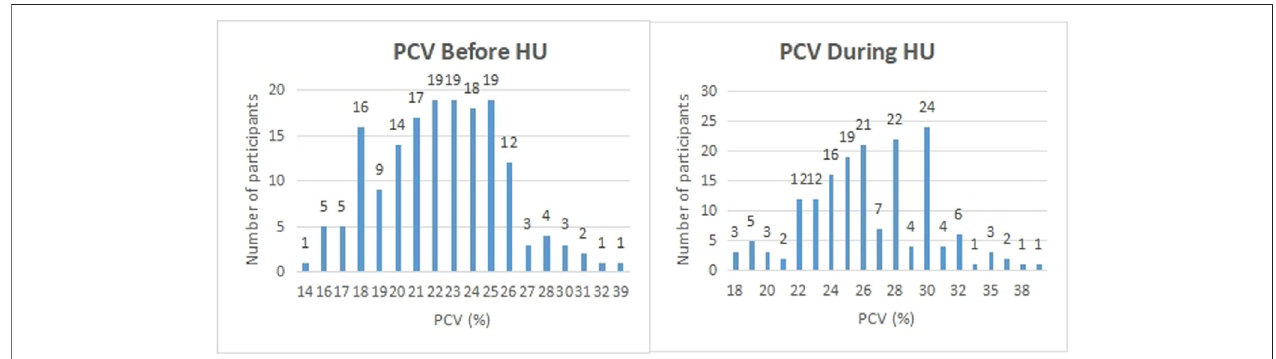
FIGURE 4 | Participants were asked what their PCV was before and during the period of hydroxyurea treatment. The PCV (%) reported by participants are shown on the x-axis while the number of participants on the y-axis.